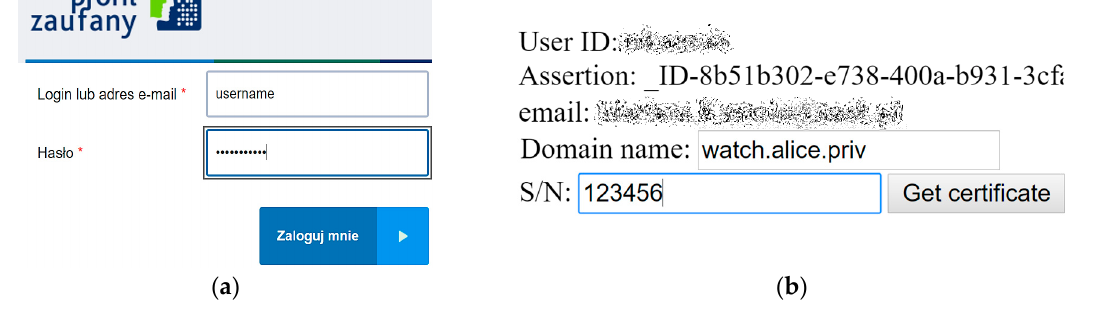
Figure 4. ( a ) PZ (Profil Zaufany) login form after redirection; ( b ) eGO-DANE certificate customization